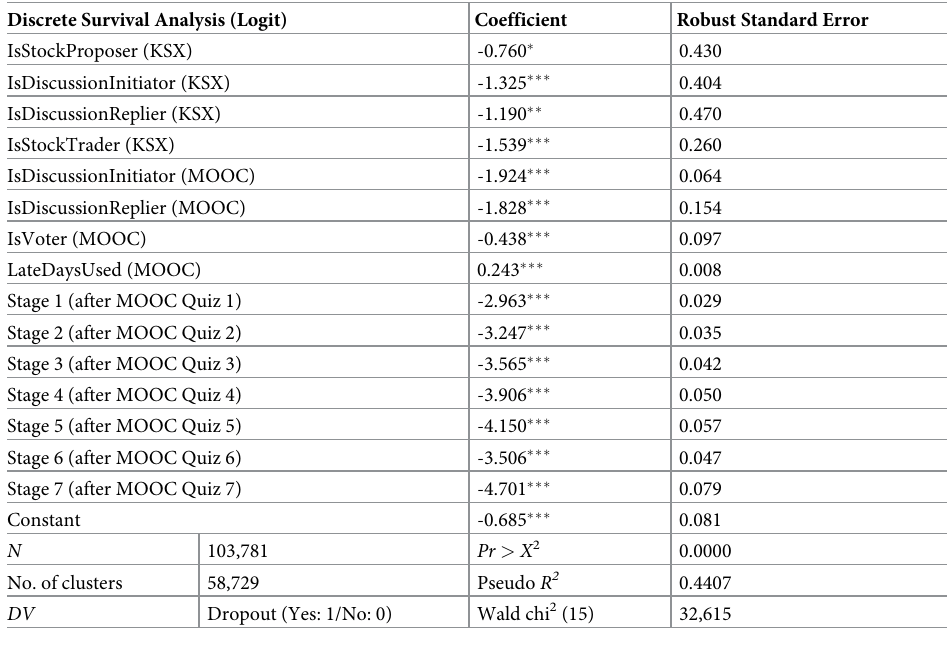
Table 6. Effect of MOOC and KSX Activity on MOOC